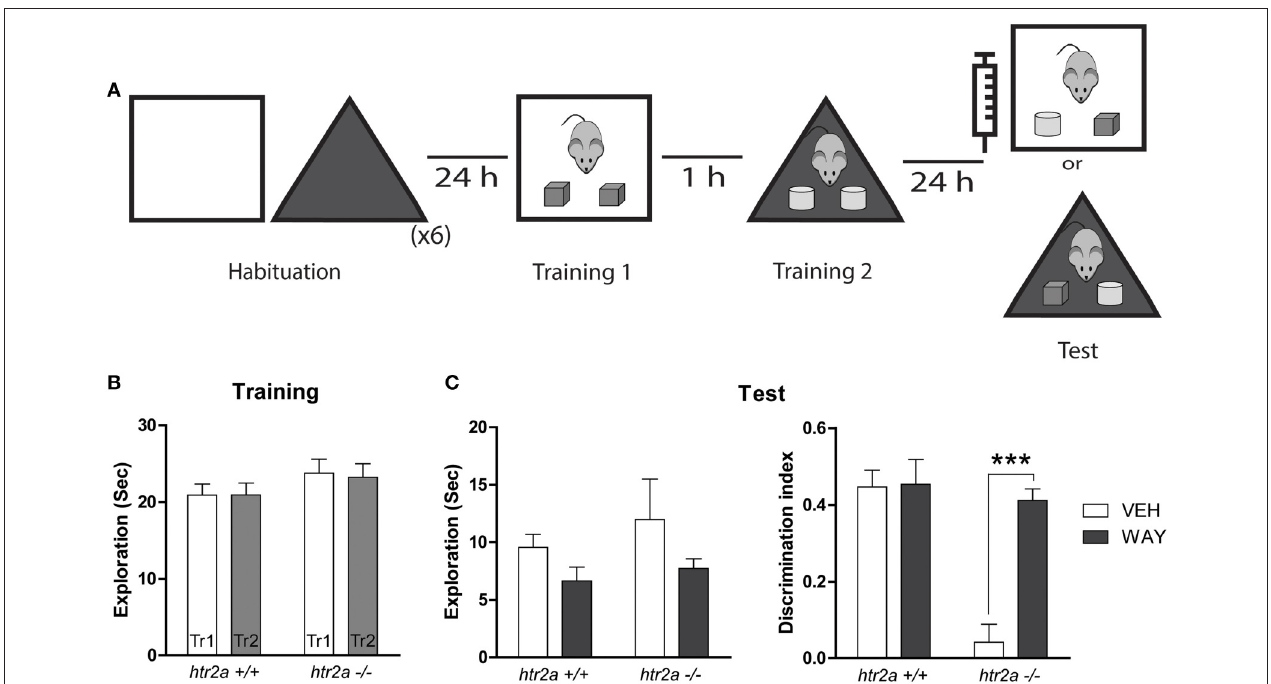
FIGURE 5 | Blockade of 5-HT1AR rescues the phenotype observed in the OIC task in htr2a − / − (A) Training and test scheme for the object-in-context (OIC) task. Fifteen minutes before the test session mice were infused with 1 µ g/side of WAY 100135 or vehicle (VEH) into the mPFC. (B) Exploration time measured in seconds made by the mice during the first and the second Training phases (Tr 1 and Tr2). (C) Total exploration measured in seconds (left) and Discrimination Index (right). Discrimination index was calculated as the time spent exploring the incongruent object minus the time spent exploring the congruent one over the total exploration time during the test session. n = 6 per group, *** p < 0.0001 , Two-way repeated measured ANOVA followed by Bonferroni‘s post-hoc test.